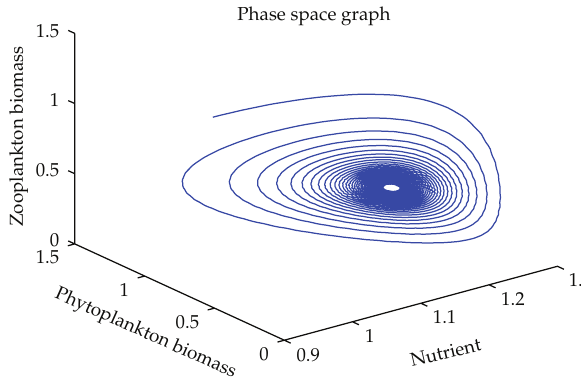
Figure 3: Stable phase-space diagram for the system with nutrient, phytoplankton, and zooplankton at α (cid:7) 1 . 25.